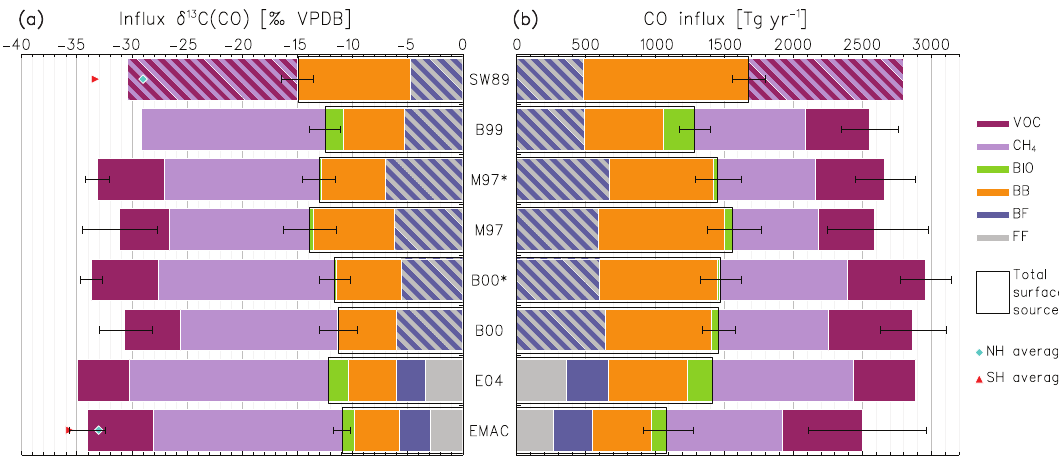
Figure 9. Estimates of the tropospheric CO sources and their contribution to the overall source isotope composition from previous and the present studies (refers to Table 7). Abbreviations refer to: SW89: Stevens and Wagner (1989); M97: Manning et al. (1997) (case 2); B99: Brenninkmeijer et al. (1999); B00: Bergamaschi et al. (2000) (scenario S2); E04: Emmons et al. (2004); EMAC: this study, set-up based on EVAL 2 , year 2000 (see text, Sect. 2). Asterisks denote a priori estimates of the corresponding inverse modelling studies. Note: blue-grey hatched bars denote the aggregate of industrial emissions (FF and BF sources are not distinguished); SW89 report the total of photochemical sources only (light blue-violet hatched bars, respectively). Black frames denote the values for the total surface component. (b) Source terms by category. (a) Individual contribution of each source category to the overall source δ 13 C(CO), calculated as a product of the share in total emission and respective source δ 13 C average. Symbols denote the hemispheric tropospheric averages, where